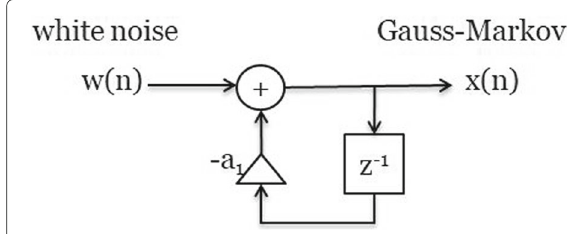
Fig. 21 GM process generator structure